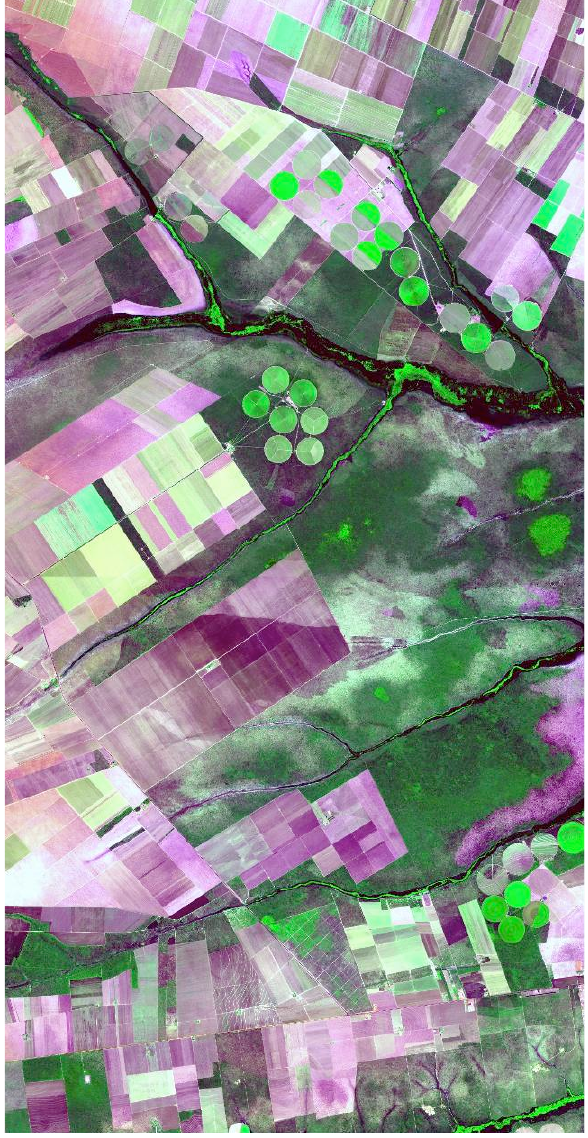
Figure 11 – Simulated MUX/CBERS-3 – Colored Composition